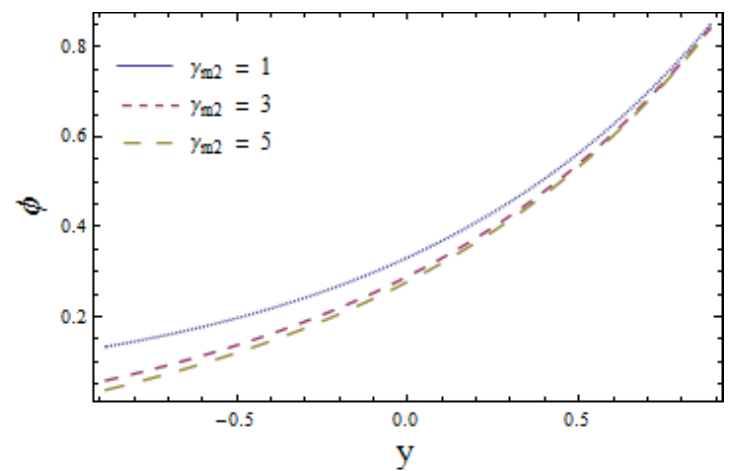
Figure 16. Mass concentration φ versus y for γ m 2 when (cid:101) = 0.2, τ ∗ = 2, x = 0.1, t = 0.1, γ h 1 = 6, γ h 2 = 8, γ m 1 = 6, γ = 1 and Sc = 0.5.